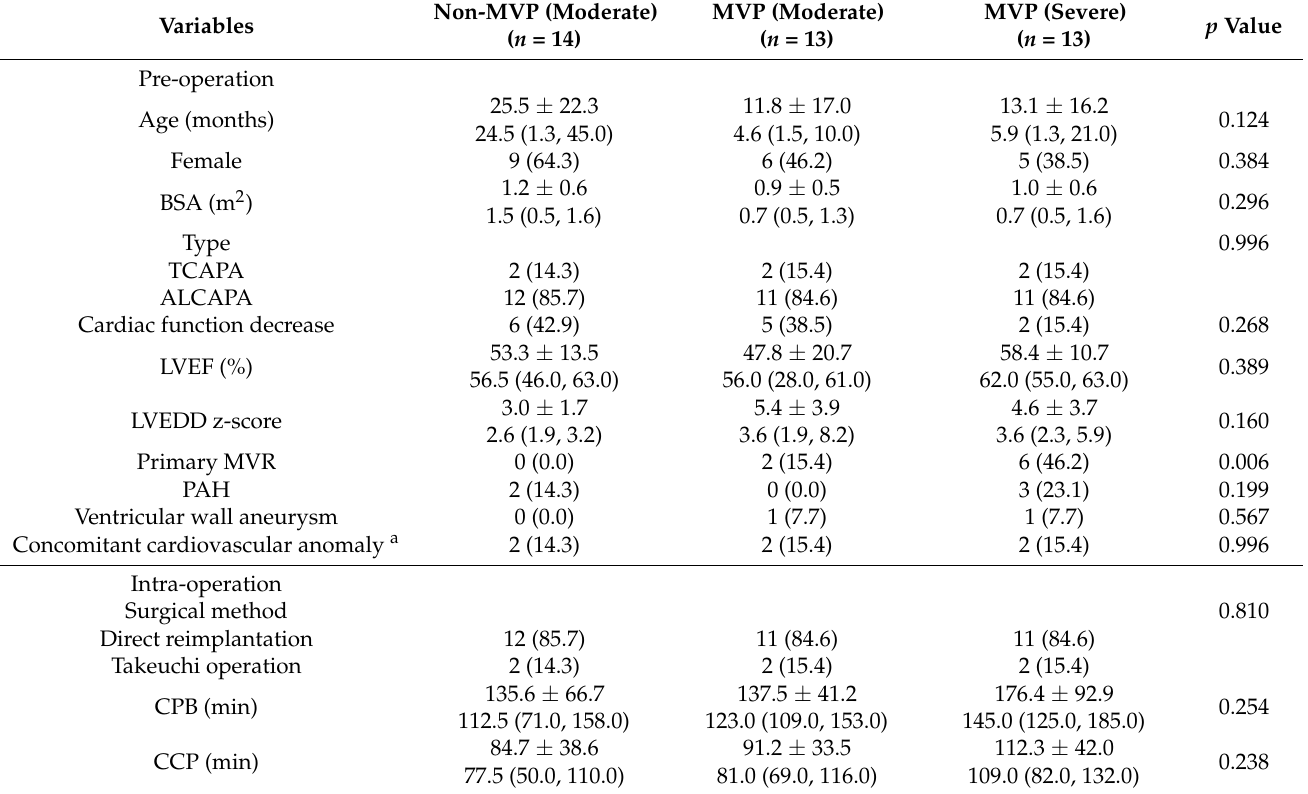
Table 1. Baseline characteristics of ACAPA patients with and without mitral valve